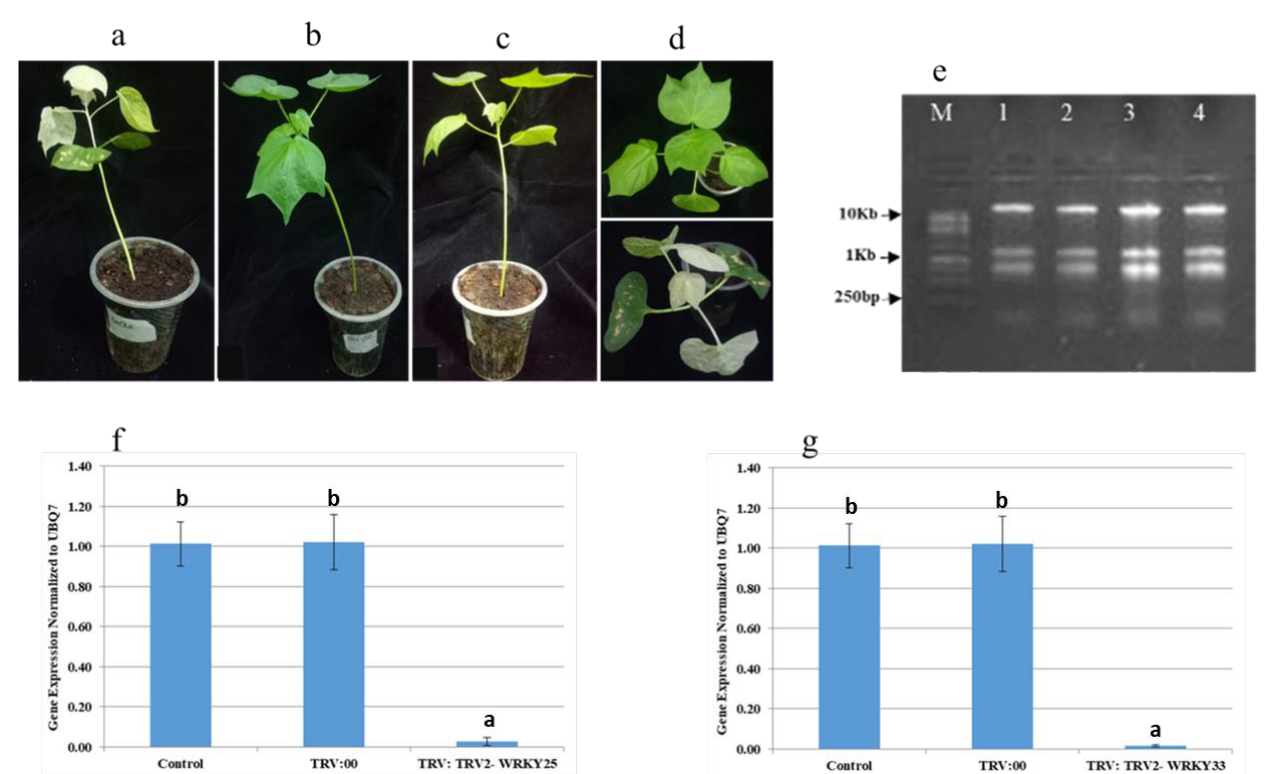
Figure 5. VIGS-based functional analysis of GhWRKY25 and GhWRKY33 genes in cotton. ( a – d ) Photobleaching appeared in TRV:TRV2-GrCla-infiltrated G. hirsutum plants, while no phenotypic